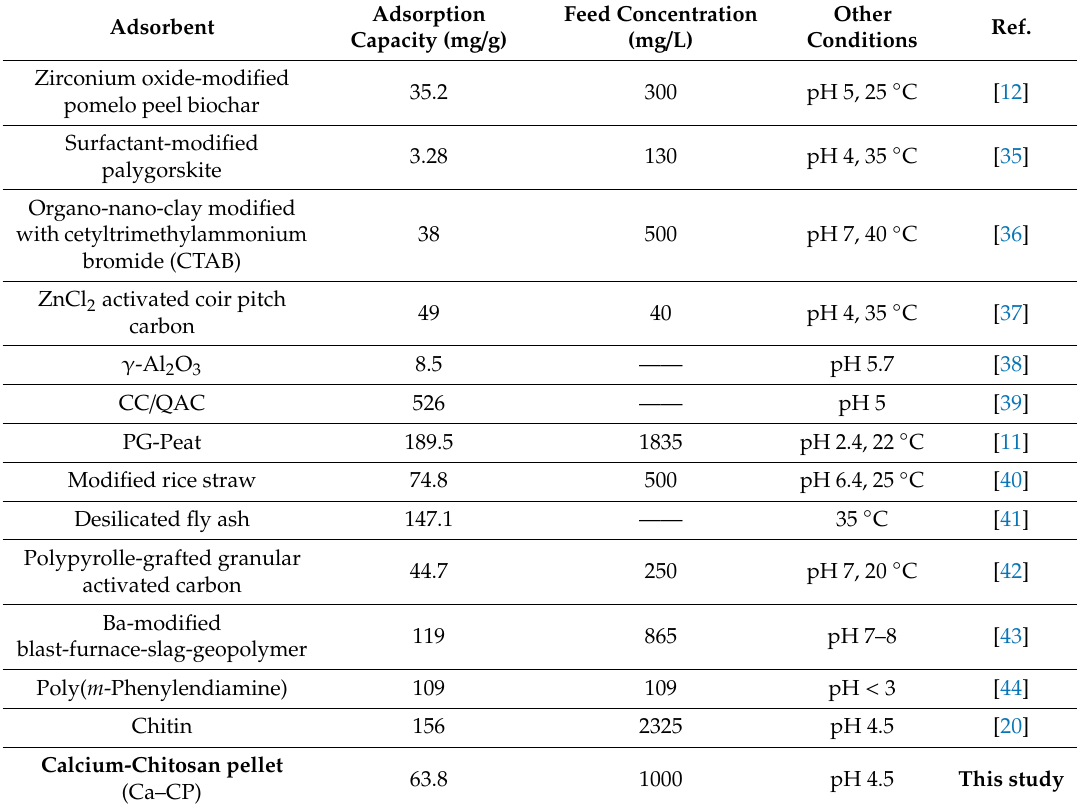
Table 7. Comparison of maximum adsorption capacity of Ca–CP with various sulfate